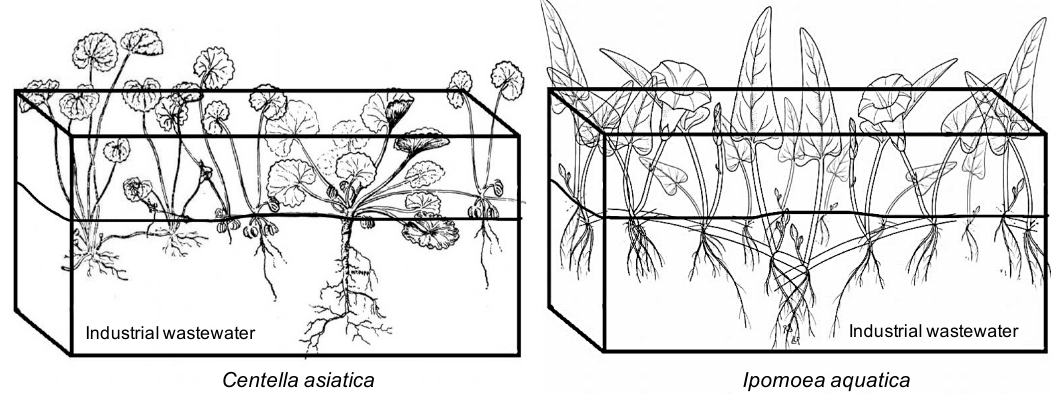
Figure 1. Schematic of the aquatic plant germination in a reservoir.